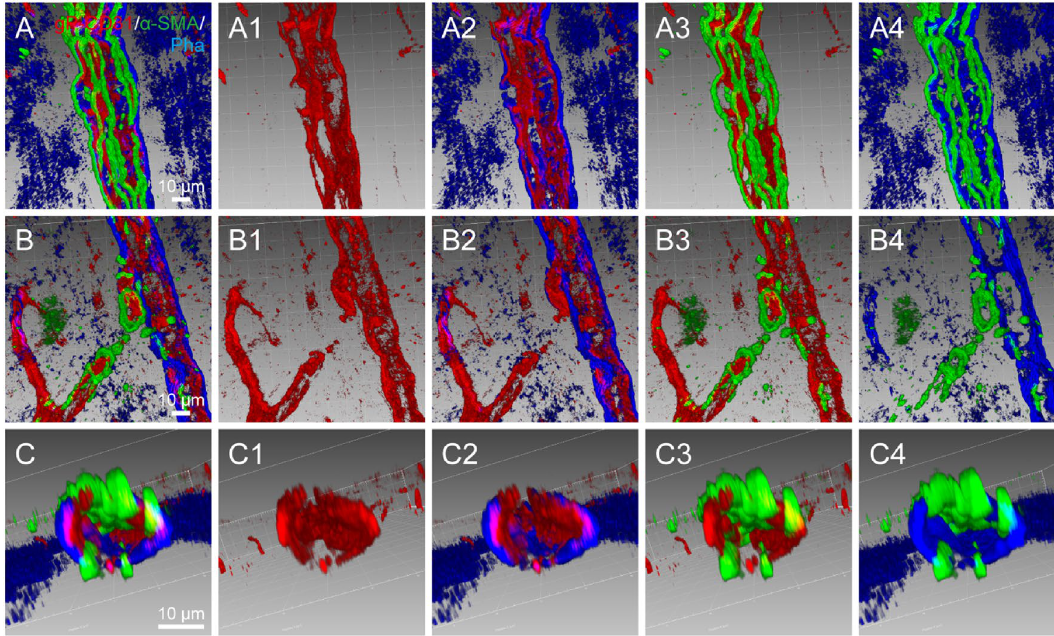
Figure 7. Spatial correlation of vascular labeling among goat polyclonal anti-CD31 (gP-CD31), phalloidin and alpha smooth muscle actin (α-SMA). ( A – C ) Representative adjusted images from the cerebral cortex showing the spatial correlation of vascular labeling of gP-CD31, phalloidin and α-SMA along the longitudinal axis of penetrating artery ( A ) and intracerebral capillaries ( B ), as well as with the transverse view of penetrating artery ( C ) in three-dimensional pattern. ( A1 – A4 ), ( B1 – B4 ), ( C1 – C4 ) Corresponding images from panels ( A – C ) showing the vascular labeling with gP-CD31 ( A1 – C1 ), gP-CD31 and phalloidin ( A2 – C2 ), gP-CD31 and α-SMA ( A3 – C3 ), phalloidin and α-SMA ( A4 – C4 ), respectively. Same scale bar for ( A – A4 ), ( B – B4 ), ( C – C4 ),